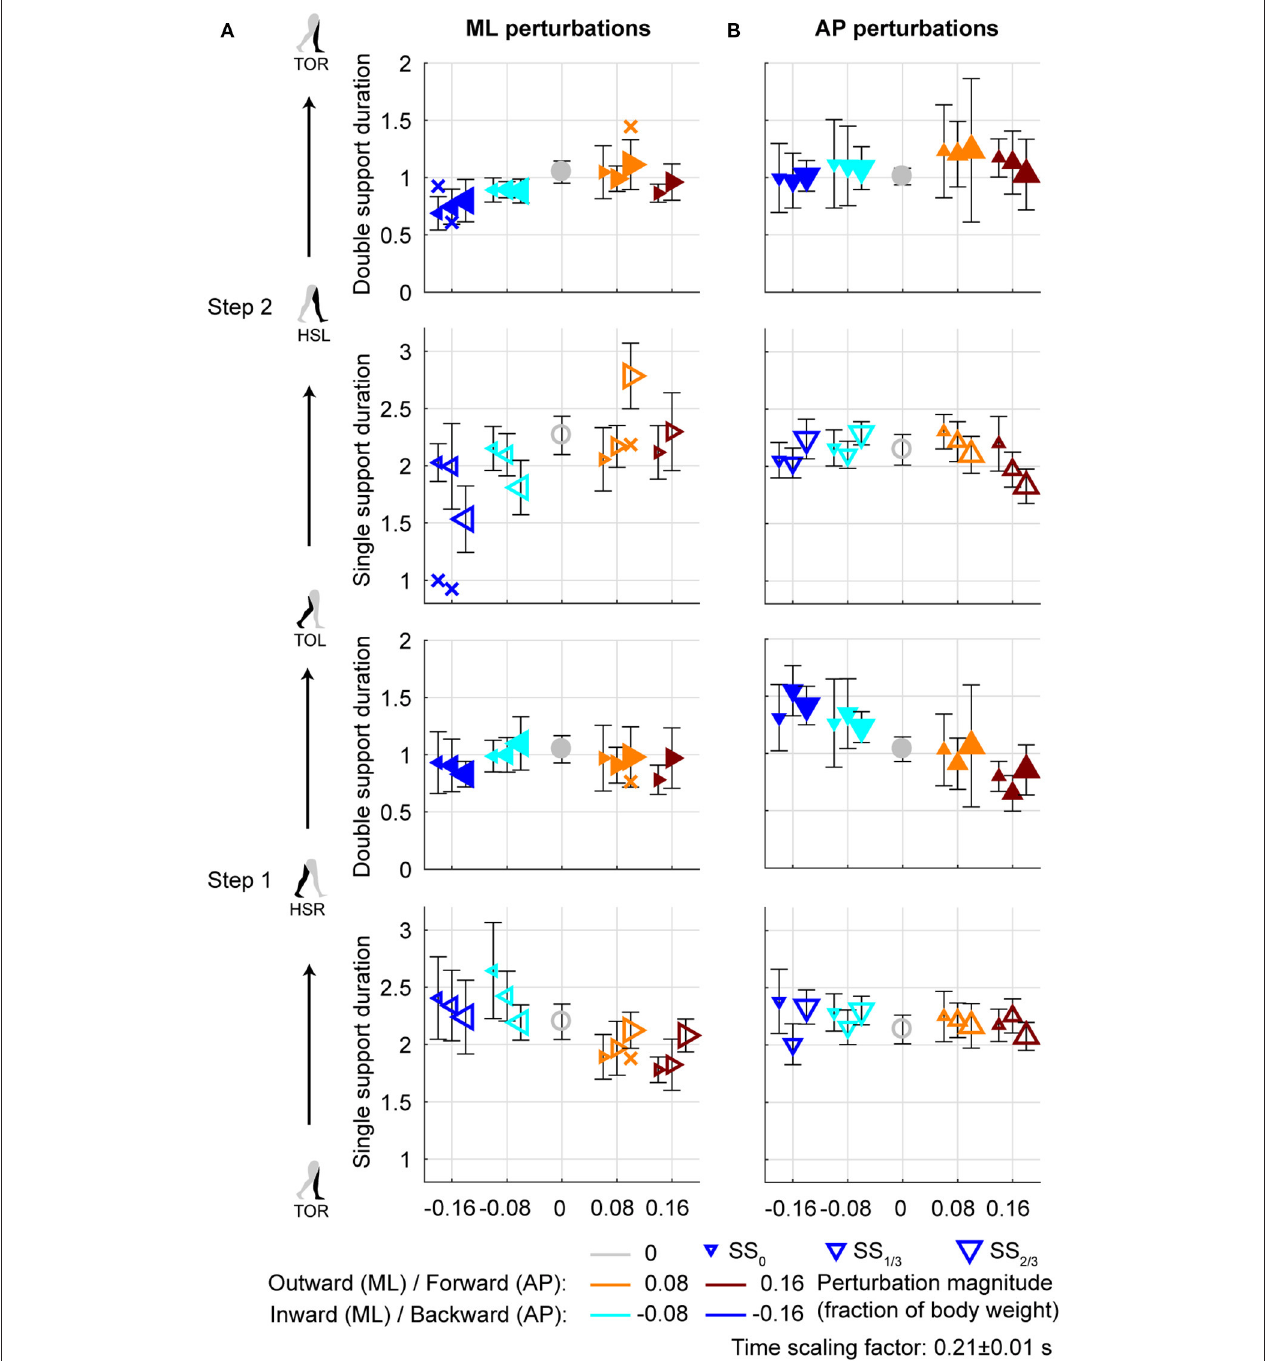
FIGURE 6 | Gait phase durations. (A) Gait phase durations following ML perturbations. (B) Gait phase durations following AP perturbations. The individual subjects with an alternative strategy for step 2 are shown separately with a cross. Triangles show subject-averages and indicate the perturbation direction. Larger marker size corresponds with later perturbation onset. Error bars represent the subject-standard deviation. Open and filled markers correspond to the single and double support phases, respectively. Colors indicate the different perturbation magnitudes. Data is shown dimensionless.